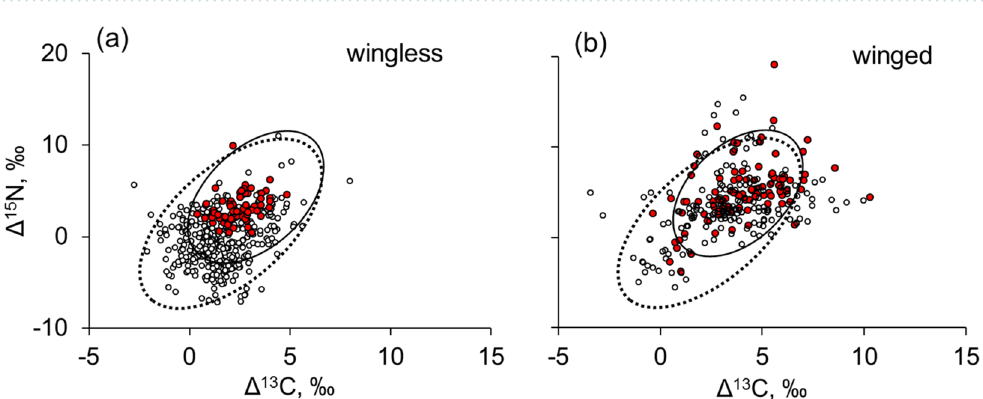
Figure 4. Stable isotope composition (litter-normalized Δ 13 C and Δ 15 N values) of wingless ( a ) and winged ( b ) arthropods within the arthropod rain throughout the vegetation season. Predators and parasitoids are shown as red dots, phytophages and microbi/saprophages as open dots. Standard ellipses for the arthropod rain and soil invertebrates are shown as dashed and solid black lines,